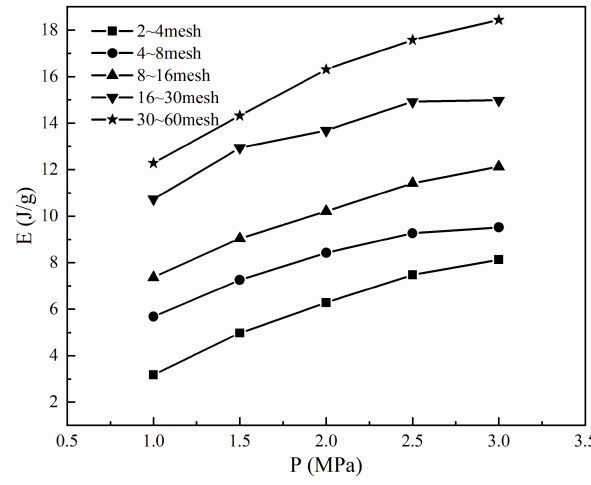
Figure 7. Variation in unit adsorption heat with